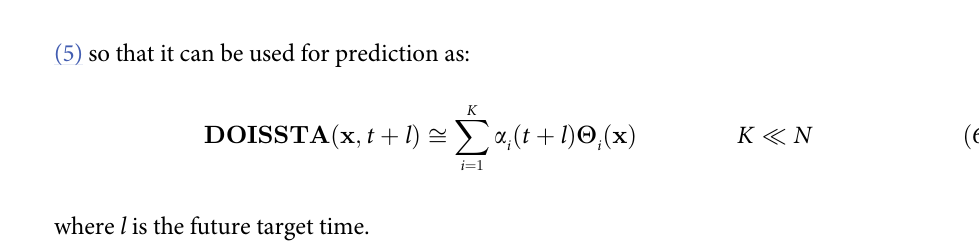
Fig 3. Schematic diagram of the analytical procedure involving the POD method used in the present study.